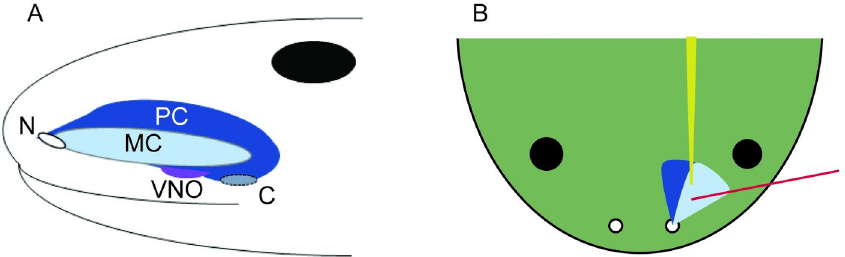
Fig 1. Location of the water nose and electrode placement. The medial cavity (MC, light blue) or water nose is a blind-ended compartment, opening only at the naris (N). The principal cavity (PC, dark blue) or air nose is a separate compartment that connects the naris to the oral cavity via the choana (C). The vomeronasal organ (VNO, purple) sits in the inferior aspect of the PC. Large black dots represent the animal’s eyes. (A) Schematic of olfactory anatomy, lateral view, as described by Reiss & Eisthen, 2014 [5]. (B) Schematic of experimental preparation, dorsal view. The EOG recording electrode is shown in red; it was placed along the medial wall of the MC. The profusion system that was used to deliver stimuli is represented in